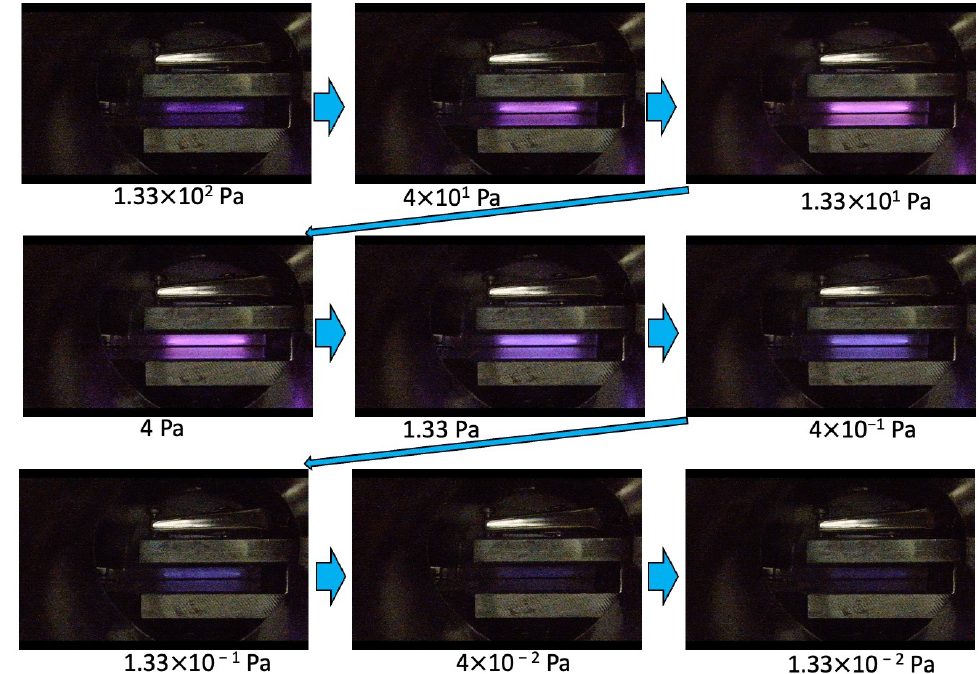
Figure 4. Pictures of glow discharge inside the electrodes at each pressure.